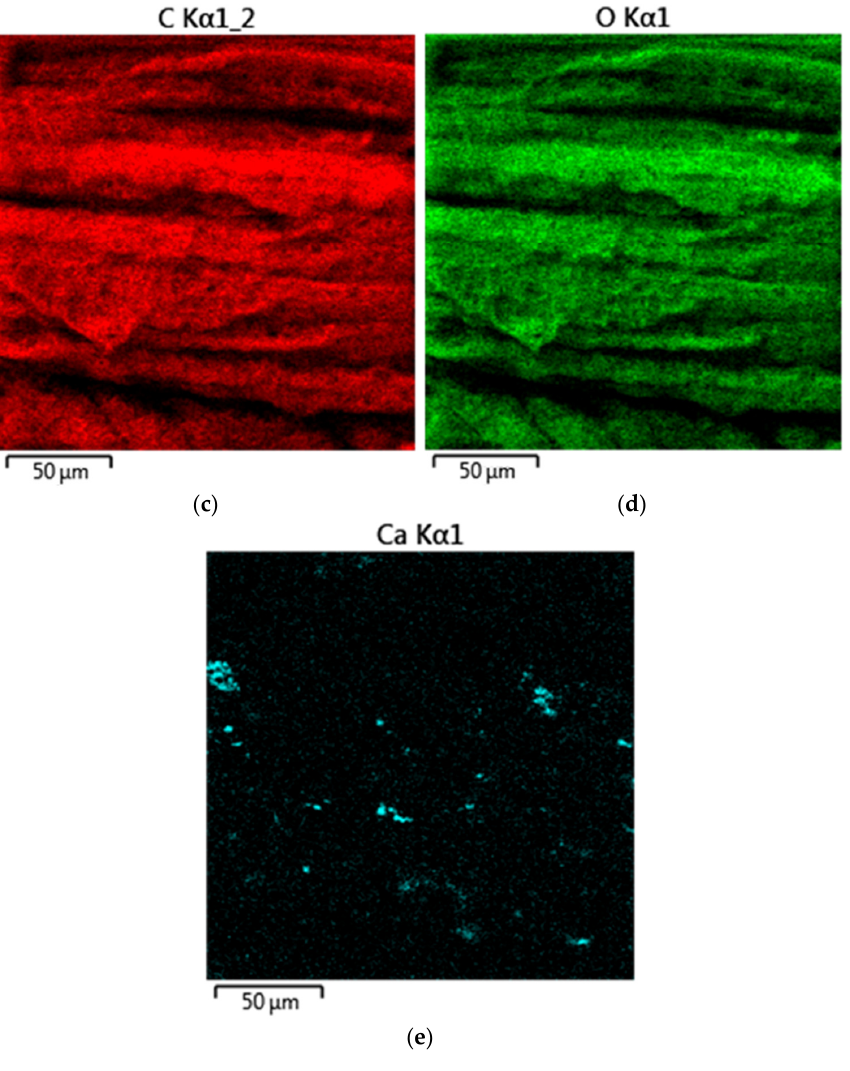
Figure 17. Control sample of suture material: ( a )—SEM micrograph, ( b )—multilayer map of EDS, ( c )—elemental map of EDS (C), ( d )—elemental map of EDS (O) and ( e )—elemental map of EDS (Ca).